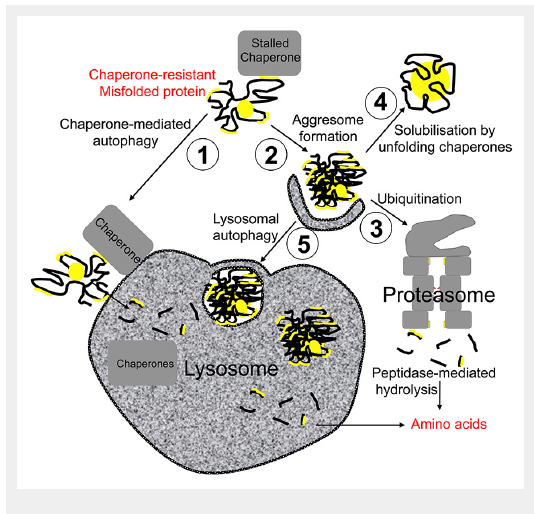
Compaction and degradation of irreversibly damaged polypeptides by the lysosome and the proteasome. When an irreversibly damaged polypeptide is over-sticky and is stalling an unfolding chaperone such as HSC70, the chaperone can target the polypeptide to the lysosome surface (step 1), where it will be specifically imported by specific transporters and degraded by chaperone-mediated autophagy. Alternatively, it may be compacted by the aggresome machinery (step 2), ubiquitinated, unfolded and degraded by the proteasome (step 3). When not ubiquitinated, the polypeptide may be actively disaggregated by unfolding chaperones and reach the native state (step 4). Alternatively, proteasome-resistant aggresomes may become enveloped